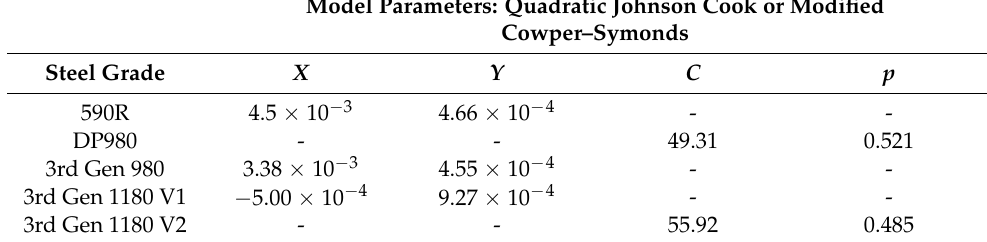
Note that a reference strain rate of 0.001 s − 1 was